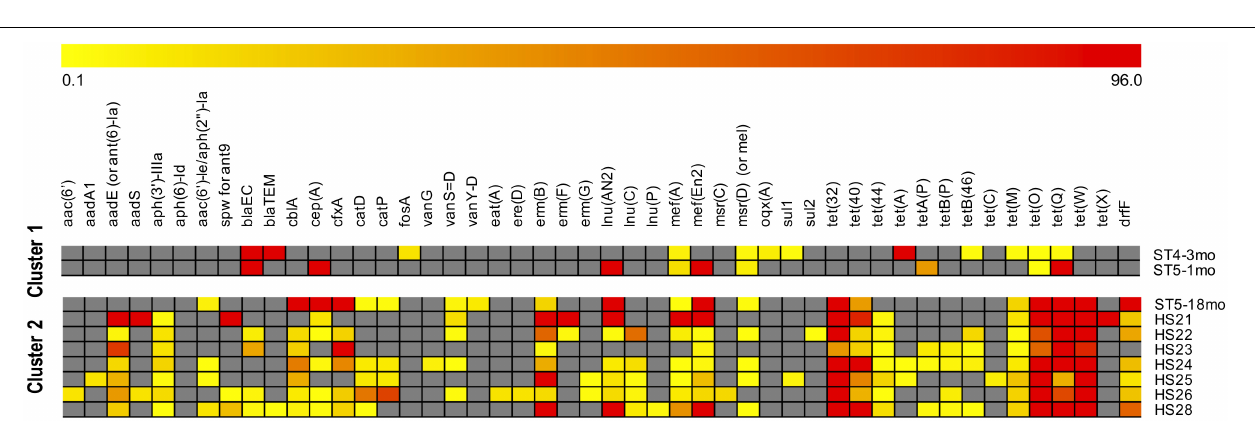
FIGURE 3 | Antimicrobial resistance genes (ARGs) abundance levels. ARGs abundance was calculated as a “mean base depth per 5 million reads” (BD5M) for each gene in each sample, and then summed for ARGs belonging to the same class of antibiotics. Each dot corresponds to a human sample ( n = 10). Median and 95% confidence intervals are represented.